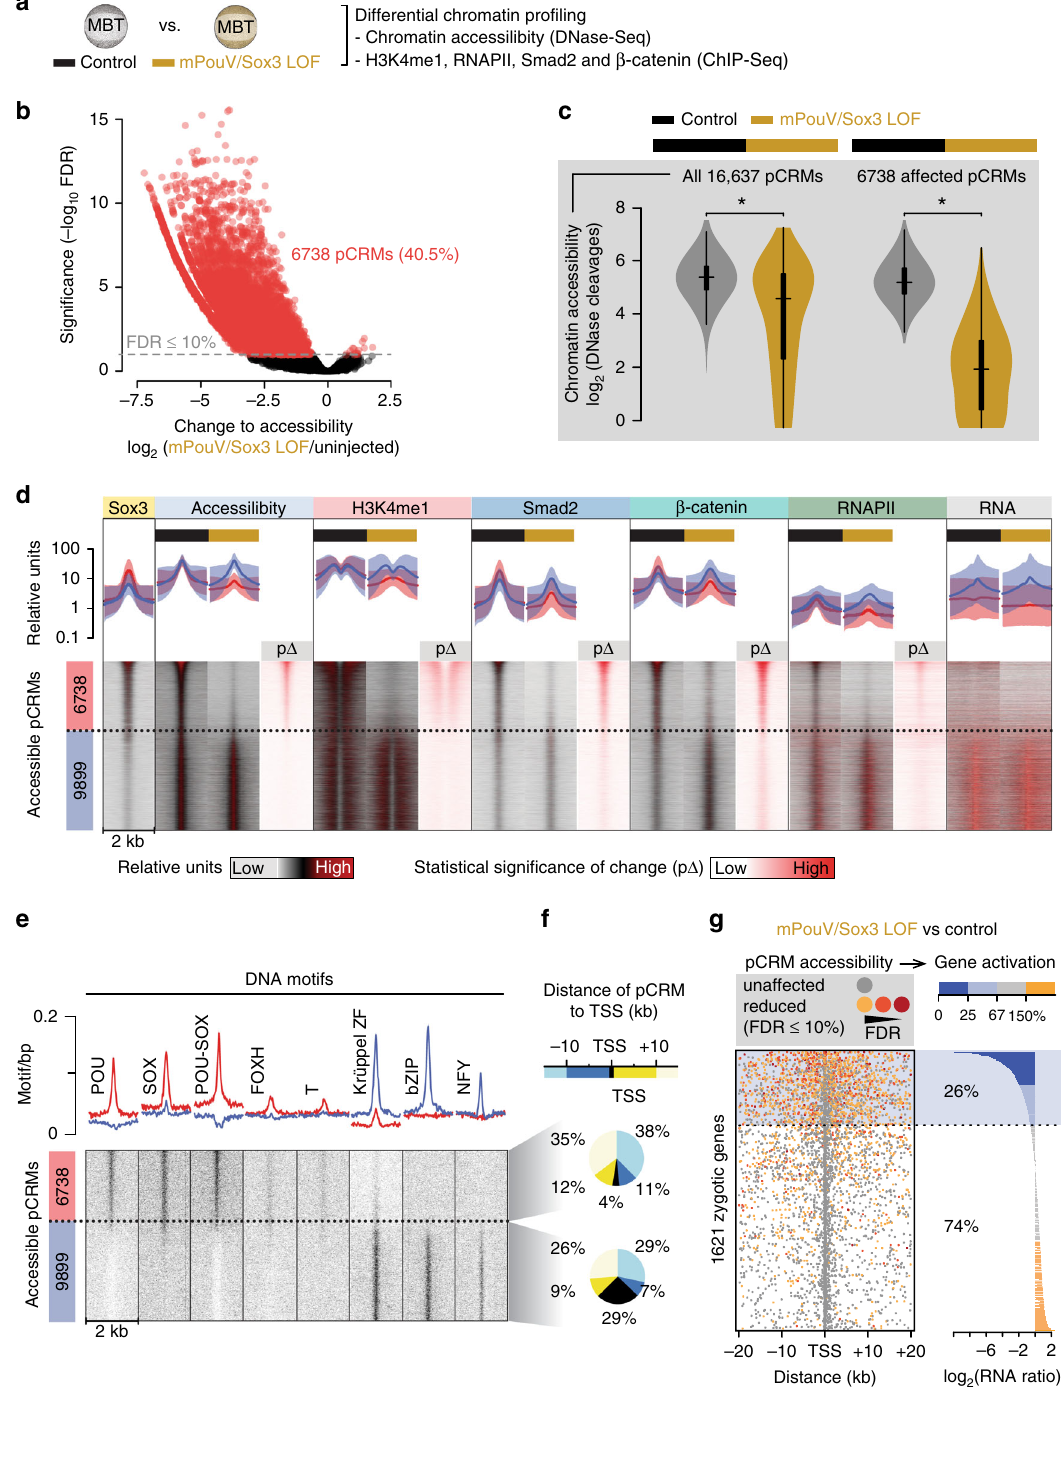
Methods Xenopus manipulations . Standard procedures were used for ovulation, fertilisa- tion, and manipulation and incubation of embryos 50,51 . Brie fl y, frogs were obtained from Nasco (Wisconsin, USA). Ovulation was induced by injecting serum gona- dotropin (Intervet) and chorionic gonadotropin (Intervet) into the dorsal lymph sac of mature female frogs. Eggs were fertilised in vitro with sperm solution consisting of 90% Leibovitz ’ s L-15 medium (Gibco) and 10% foetal calf serum (Gibco). After 10 min, fertilised eggs were de-jellied with 2.2% (w/v) L-cysteine (Sigma, 168149) equilibrated to pH 8.0. X. tropicalis embryos were cultured in 5%